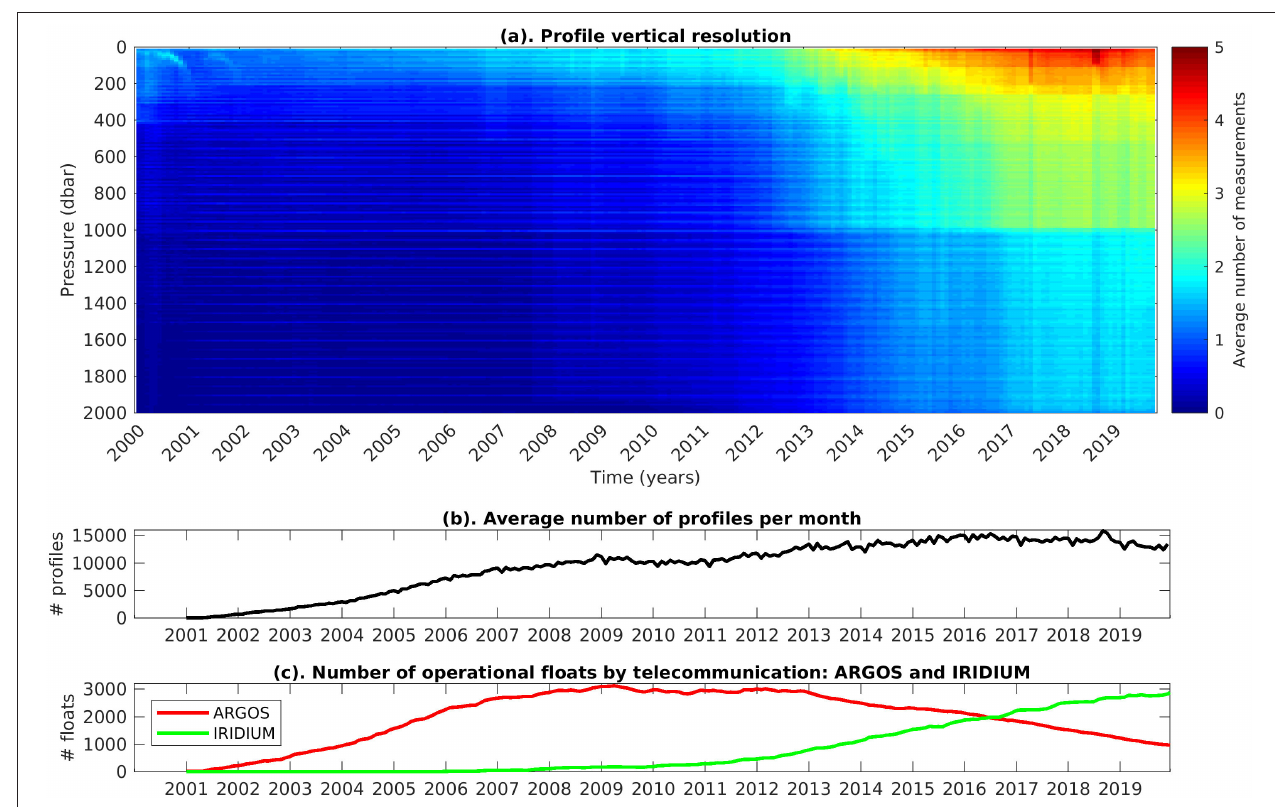
FIGURE 6 | (a) Changes in Argo CTD profile vertical resolution from year 2000 to 2019. The color bar indicates the number of measurements divided by the number of profiles in every 10-dbar bin and in every month, averaged over each year. (b) The average number of total Argo profiles per month. (c) The number of ARGOS and Iridium floats. Note that the increase in vertical resolution is due to the increase in Iridium floats.